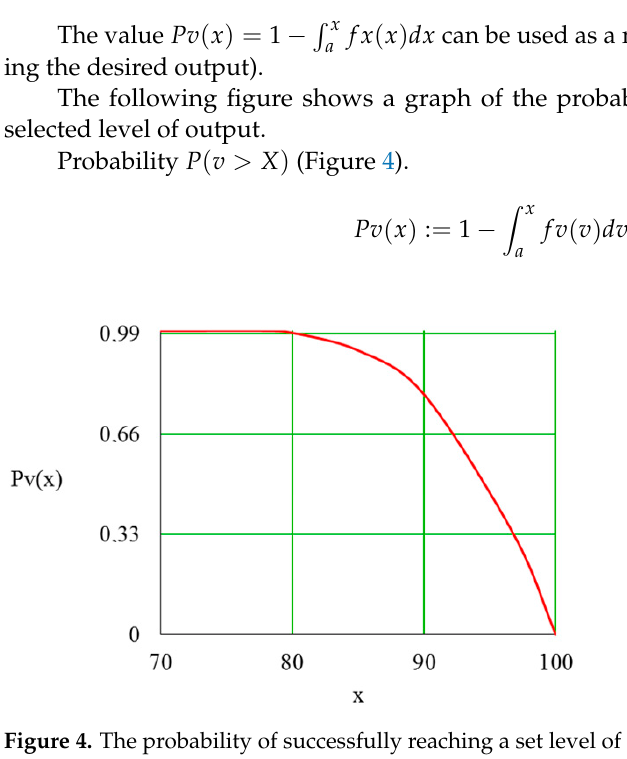
Figure 4. The probability of successfully reaching a set level of output.